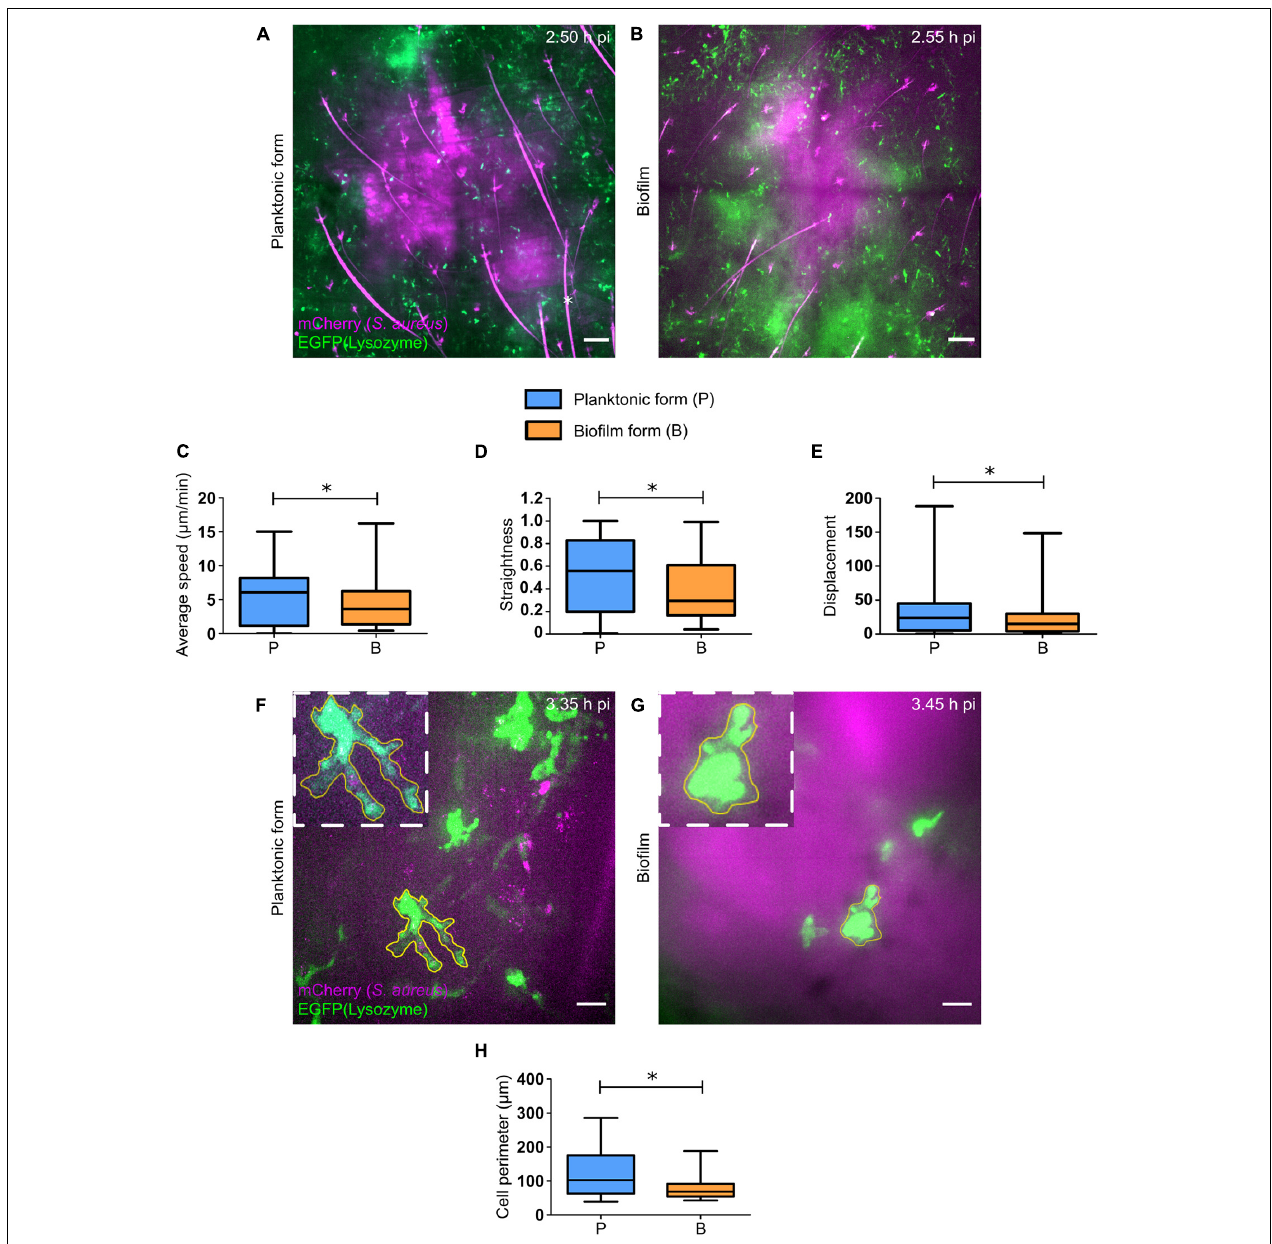
FIGURE 3 | Early dynamics of recruited EGFP + cells in the skin of S. aureus infected tissue. (A,B) Live confocal imaging, using X10 objectives, in the ear pinna tissue of LysM-EGFP transgenic mice following micro-injection of mCherry-SH1000 planktonic (A) or biofilm (B) bacteria. Average projections of green (EGFP + innate immune cells) and magenta (mCherry-SH1000) fluorescence, acquired at 2.50 h pi (A) and 2.55 h pi (B) , show immune cells recruited toward the injection site. Asterisk: autofluorescent hair (also in magenta). Scale bar: 100 µ m. One representative experiment is shown for each group of mice from at least 9 independent experiments. (C–E) Quantification of EGFP + innate immune cell average speed (C) , straightness (D) , and displacement (E) , from X20 time-lapse acquisitions of infected mice (median ± minimum and maximum values, number of cells: N P = 209, N BF = 126, from at least 3 different experiments, Mann-Whitney two-tailed test, ∗ p < 0.05). (F,G) Live confocal imaging, using X40 objectives, in the ear pinna tissue of LysM-EGFP transgenic mice following micro-injection of mCherry-SH1000 planktonic (F) or biofilm (G) bacteria. Maximum projections of green (EGFP + innate immune cells) and magenta (mCherry bacteria) fluorescence, acquired at 3.35 h pi (F) and 3.45 h pi (G) , show immune cells interacting with bacteria. The yellow line indicates the ROI where cell perimeter was measured. Scale bar: 15 µ m. One representative experiment is shown for each group of mice from at least 9 independent experiments. (H) Measure of EGFP + innate immune cell perimeter, from maximum projection time-lapse acquisitions of infected mice (median ± minimum and maximum values, number of cells: N P = 19, N BF = 25, from 4 different experiments, Mann-Whitney one-tailed test, ∗ p < 0.05).